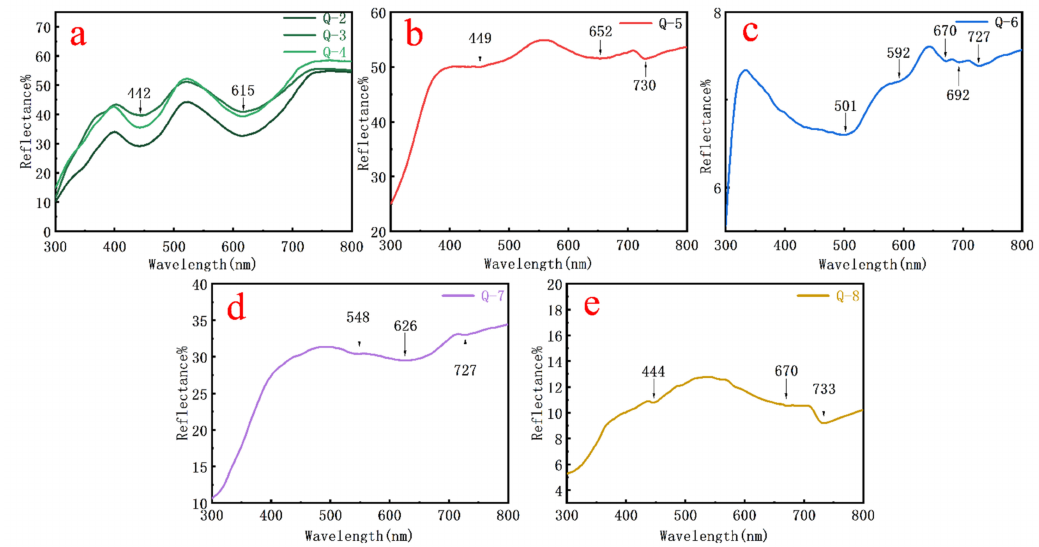
Figure 7. UV-Vis spectra for the Philippines rock samples. ( a ) UV-Vis spectra for the green samples Q-2–Q-4; ( b ) UV-Vis spectra for the cyan-gray sample Q–5; ( c ) UV-Vis spectra for the white sample with black spots Q–6; ( d ) UV-Vis spectra for the dark green sample Q–7; ( e ) UV-Vis spectra for the brown sample